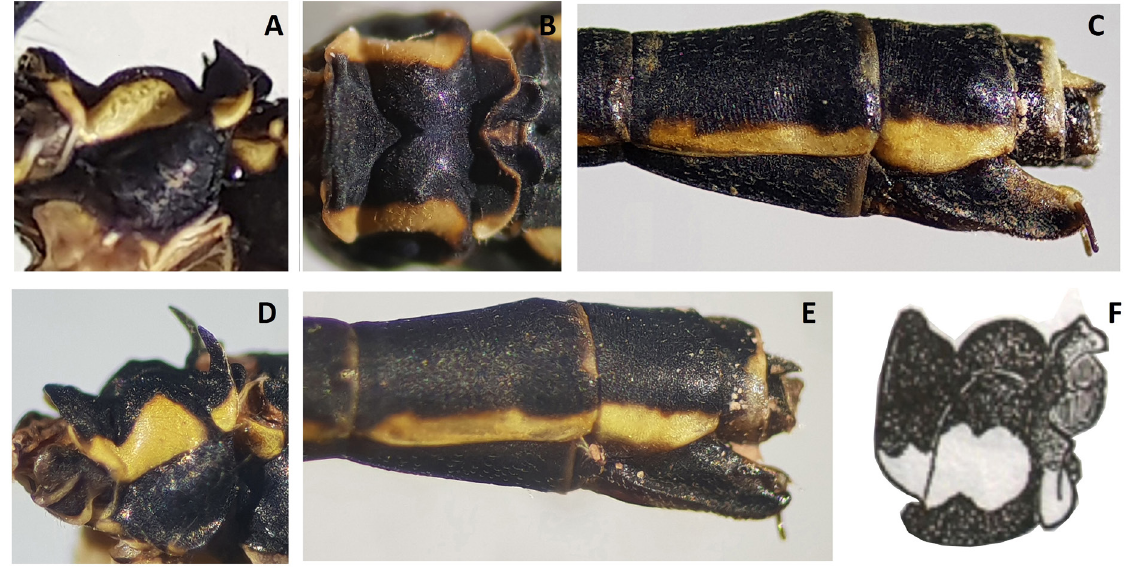
Fig. 8. Prodasineura Cowley, 1934 spp., females. A–C . P. croconota Ris, 1916, ZCDTU 2017060802- ODO. D–E . P. verticalis Selys, 1860, ZCDTU 2018030611-ODO. F . P. laidlawi (Forster in Laidlaw, 1907), modified from Asahina (1983: fig. 22). A, G–F = prothorax, lateral view; B, D = prothorax, dorsal view; C, E = tip of abdomen, lateral view. Images not to